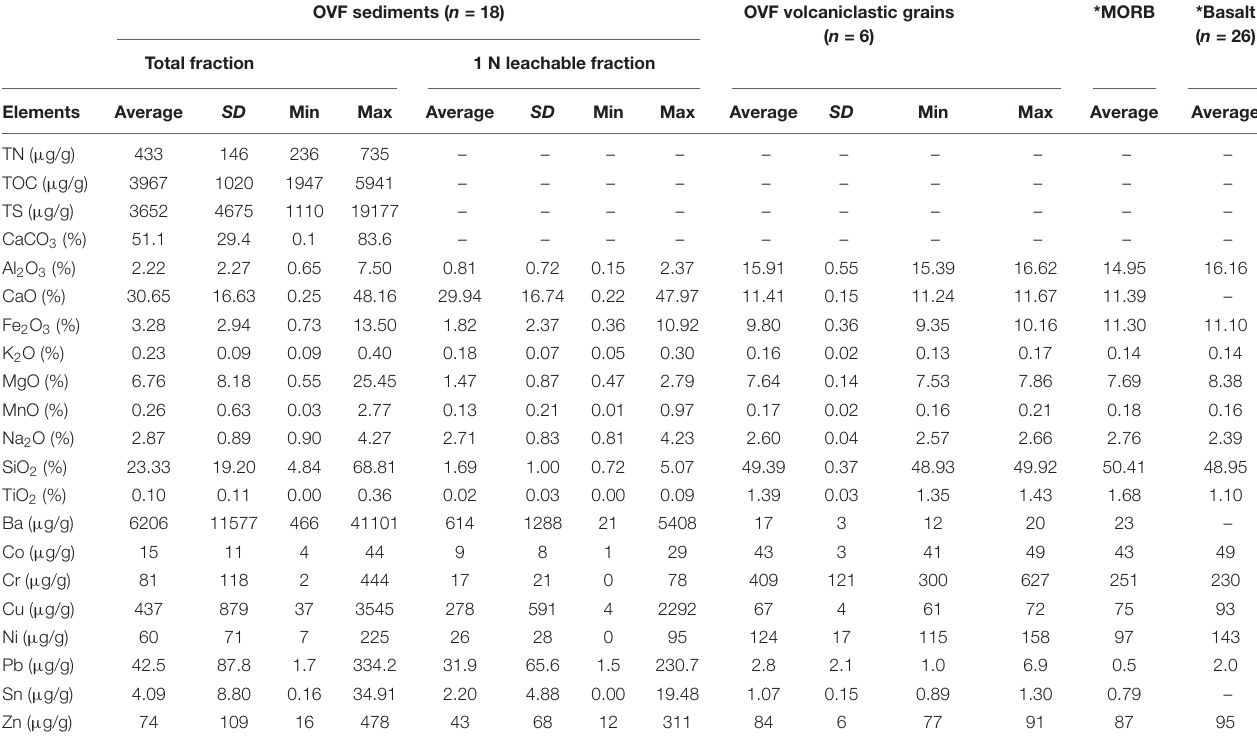
TABLE 1 | Descriptive statistics of elemental compositions for surface sediments of the study area. OVF sediments ( n = 18) OVF volcaniclastic grains